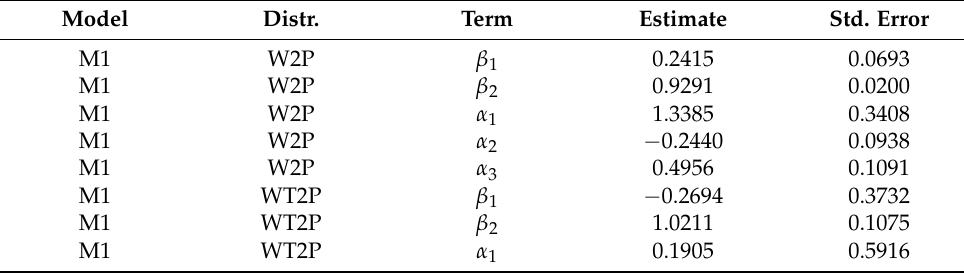
Table 3. Regression coefficients and standard errors estimated for the parameter prediction